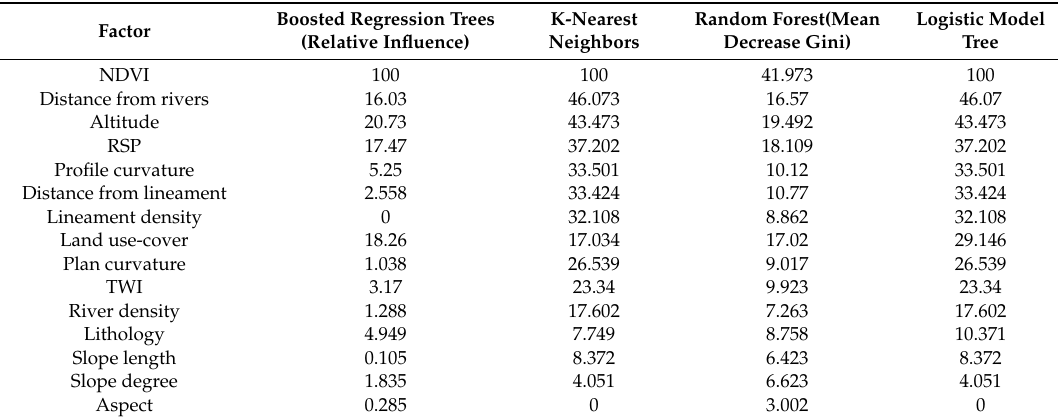
Table 6. Importance of driving factors in GW potential